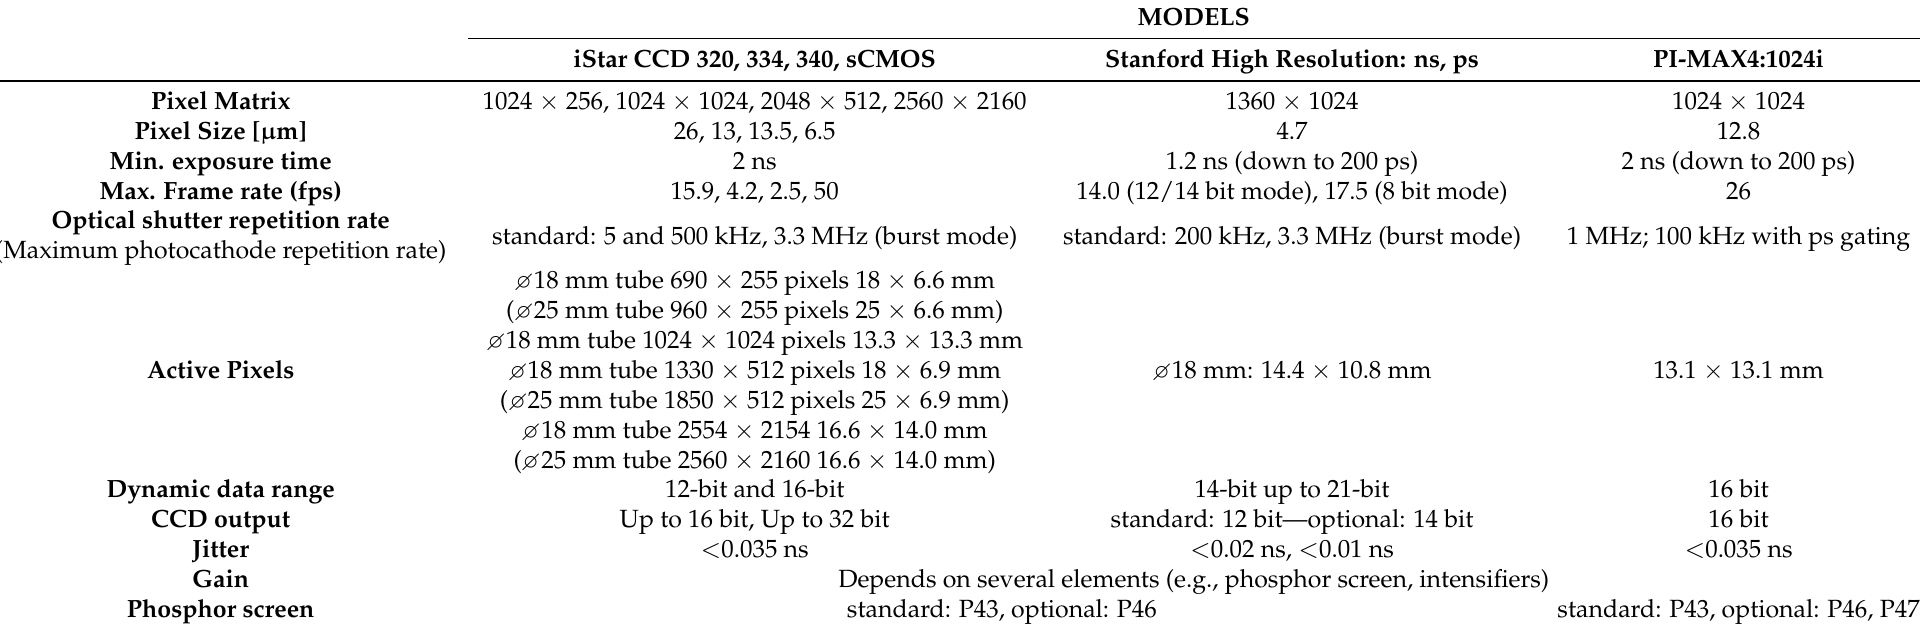
Table 7. Comparative analysis of the main commercial items: Andor [179,180], Stanford [181,182] and Princeton [183].